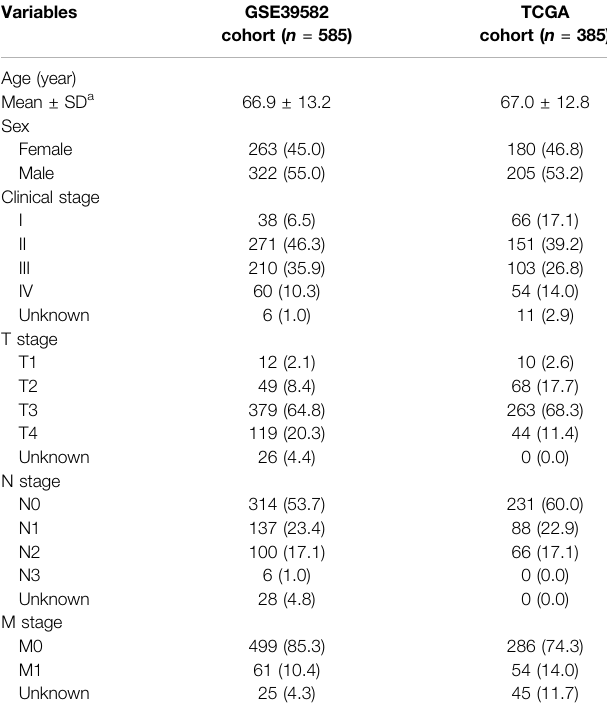
TABLE 1 | Clinicopathological features of patients with colon cancer.